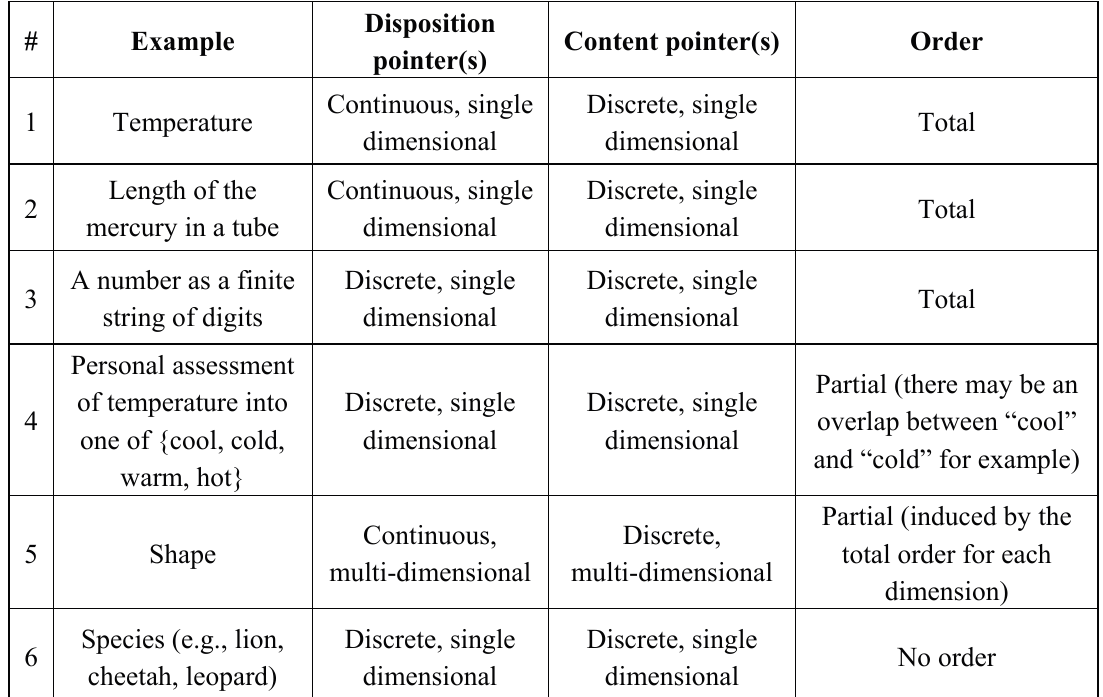
Table 3 . Characteristics of pointers.